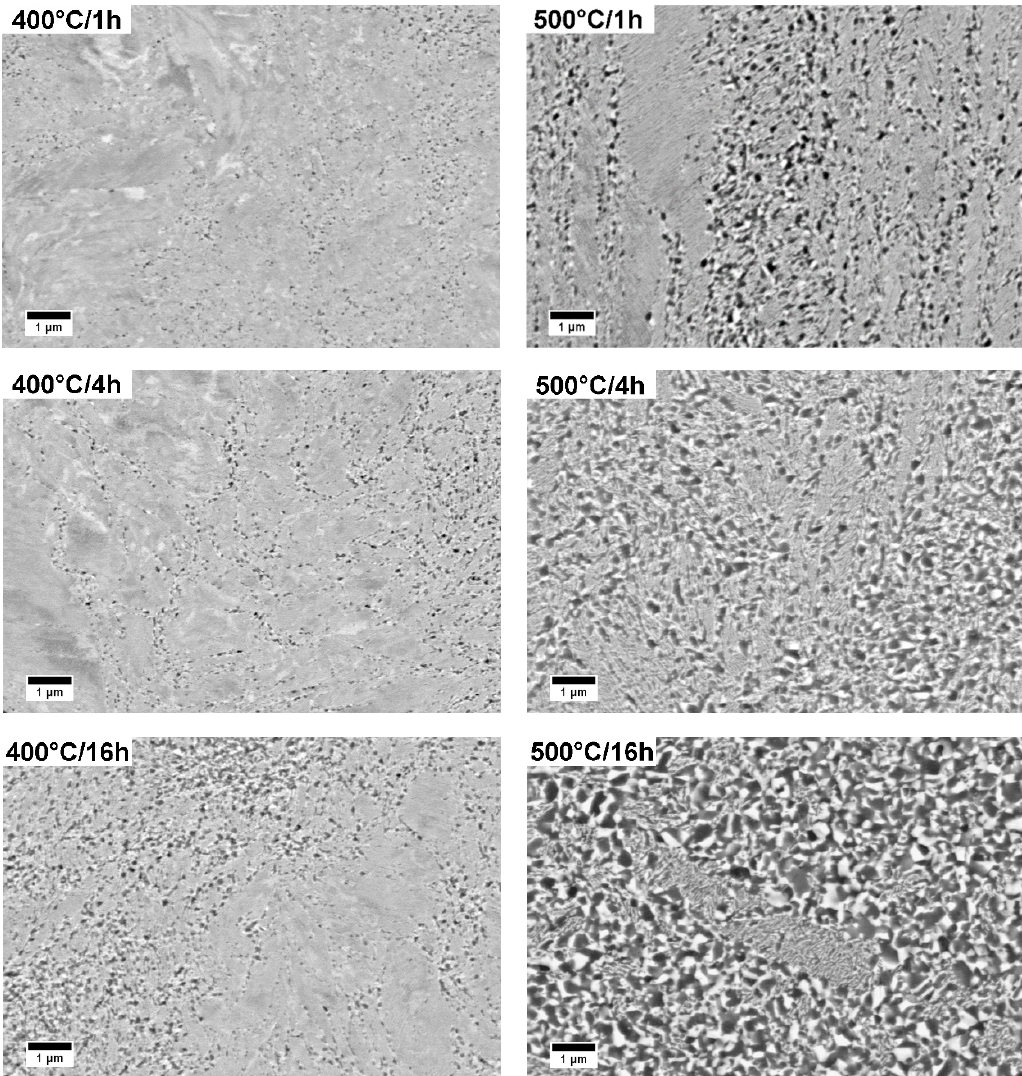
in the top left corner of each micrograph).